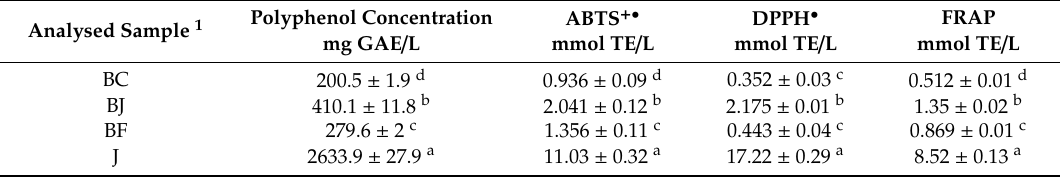
Table 2. Antioxidant activity and concentration of polyphenols in tested beers and juice pressed from the hawthorn